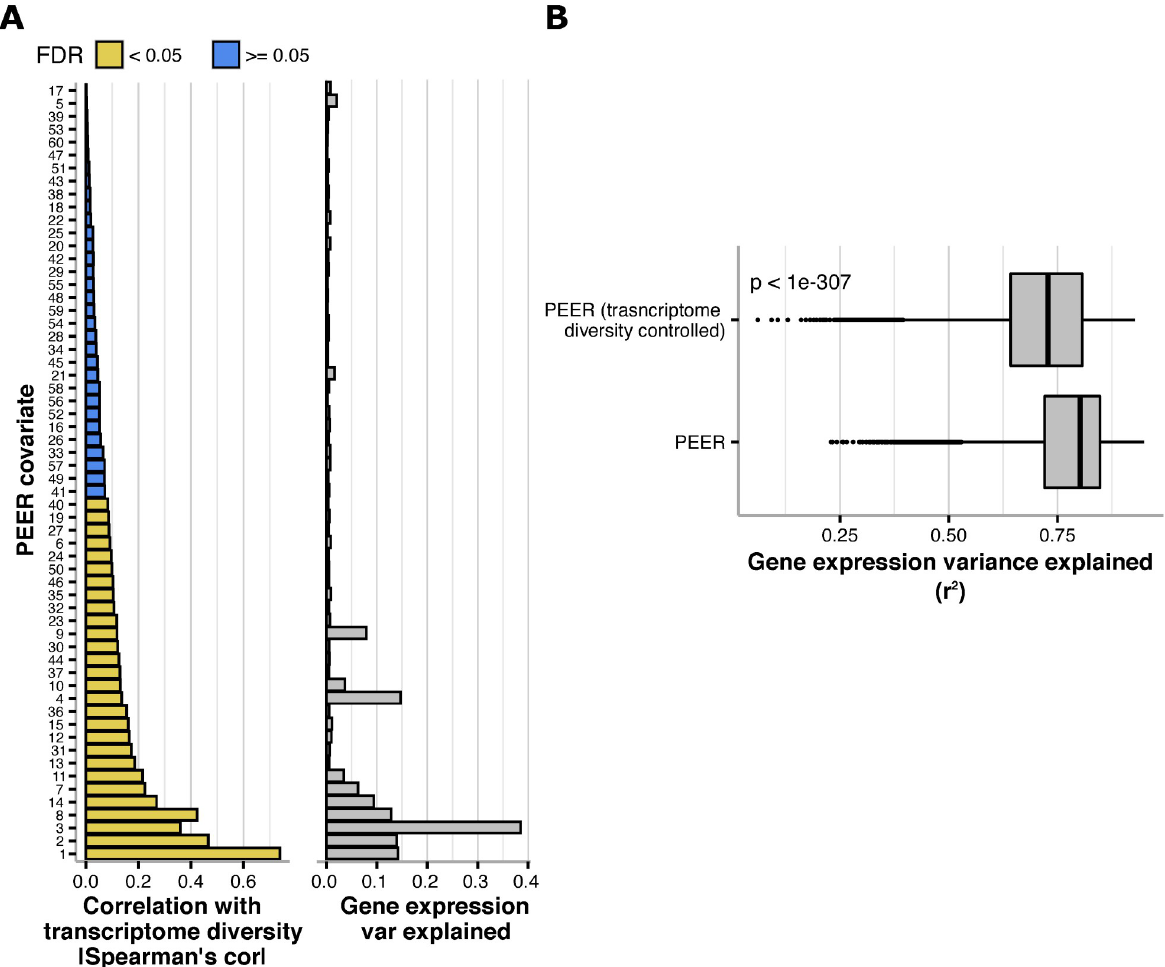
Fig 3. Transcriptome diversity is a major factor encoded in PEER covariates. A Left: Spearman correlation coefficients between transcriptome diversity values and the values of all PEER covariates obtained from the full expression matrix (see Materials and methods: Uniform processing) and colored by significance of correlation using BH-FDR. Right: Variance explained by each PEER covariate of the full expression matrix (calculated using a PCA-based method; see Materials and methods: Variance explained of gene expression matrices). B Boxplots showing the distribution of variance explained values ( r 2 ) from linear regressions done on the expression of each gene using intact PEER covariates, or the residuals of regressions performed on the same PEER covariates using transcriptome diversity (transcriptome diversity controlled, see Materials and methods: Gene expression variance explained by PEER accounted by transcriptome diversity and other covariates). The p-values from a Mann- Whitney test are shown.